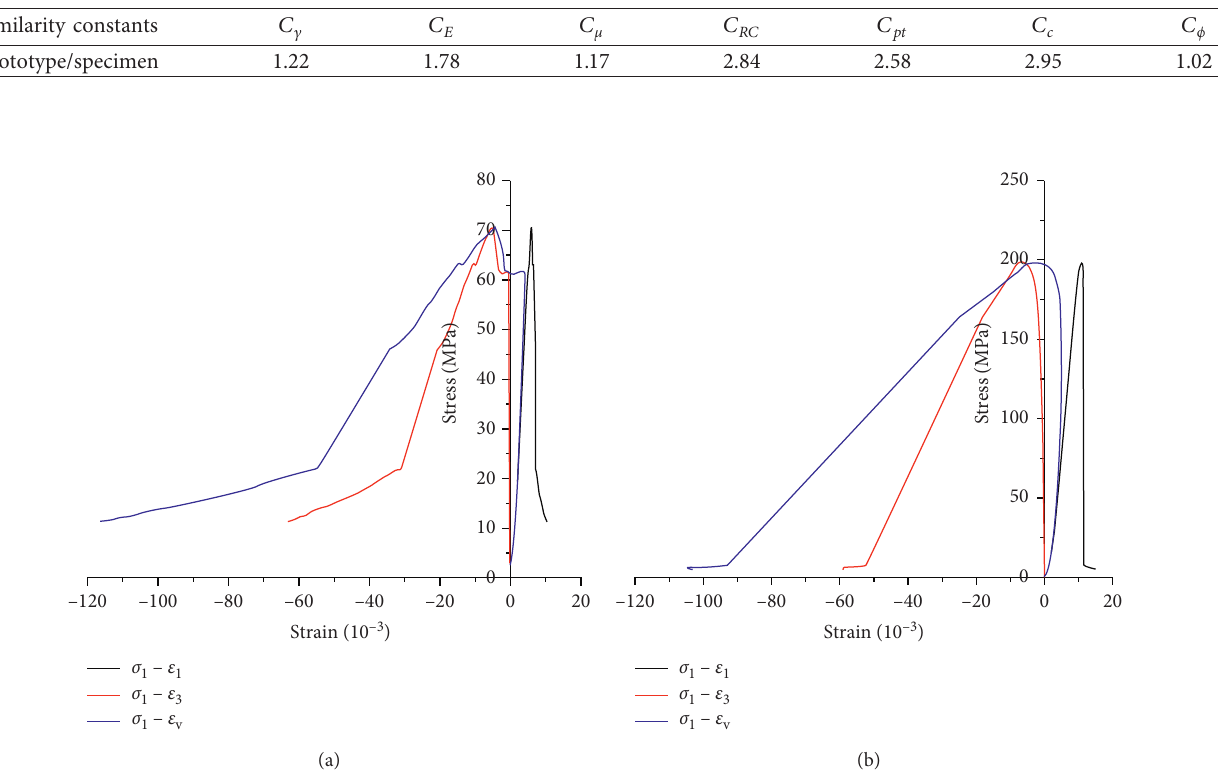
Table 2: Similarity constant about physicomechanical parameters between prototype rock and model specimen.